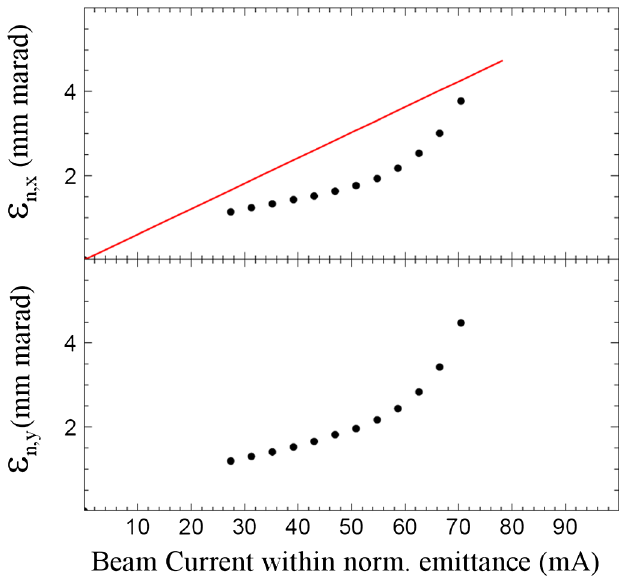
FIG. 35. The dependence of the normalized emittance at the linac exit as a function of the correspondent beam current (dots). The red line represents the upper limit for the foreseen multiturn injection